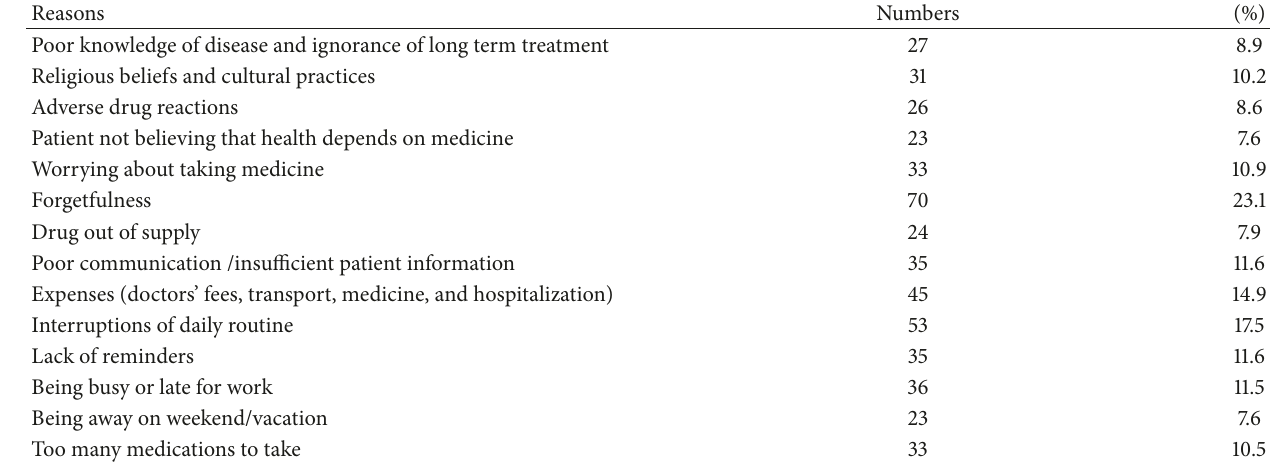
Table 5: Reasons for nonadherence of